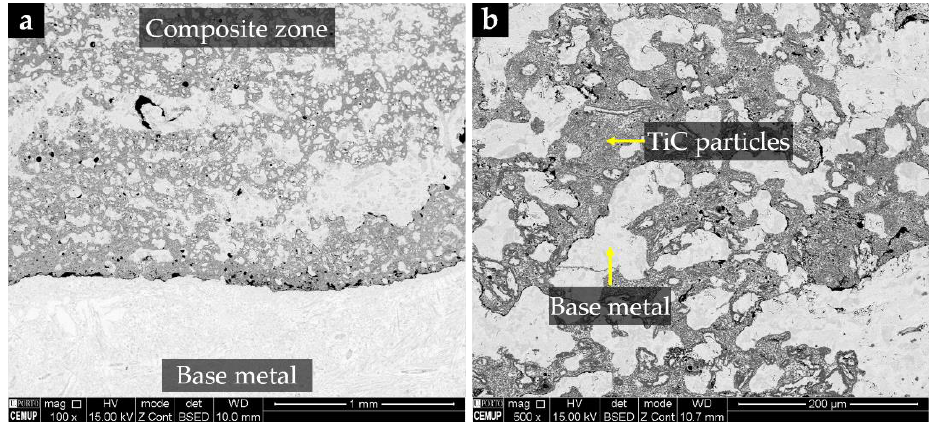
Figure 3. SEM-BSE images of the microstructure of a reinforcement produced in a high-Cr white cast iron using the Al-Ti-C powder system: ( a ) bonding zone and ( b ) metal matrix composite zone with TiC particles.